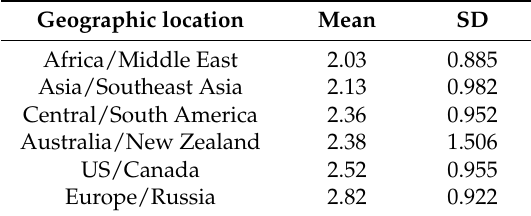
Table 29. Importance of article readings by geographic location.